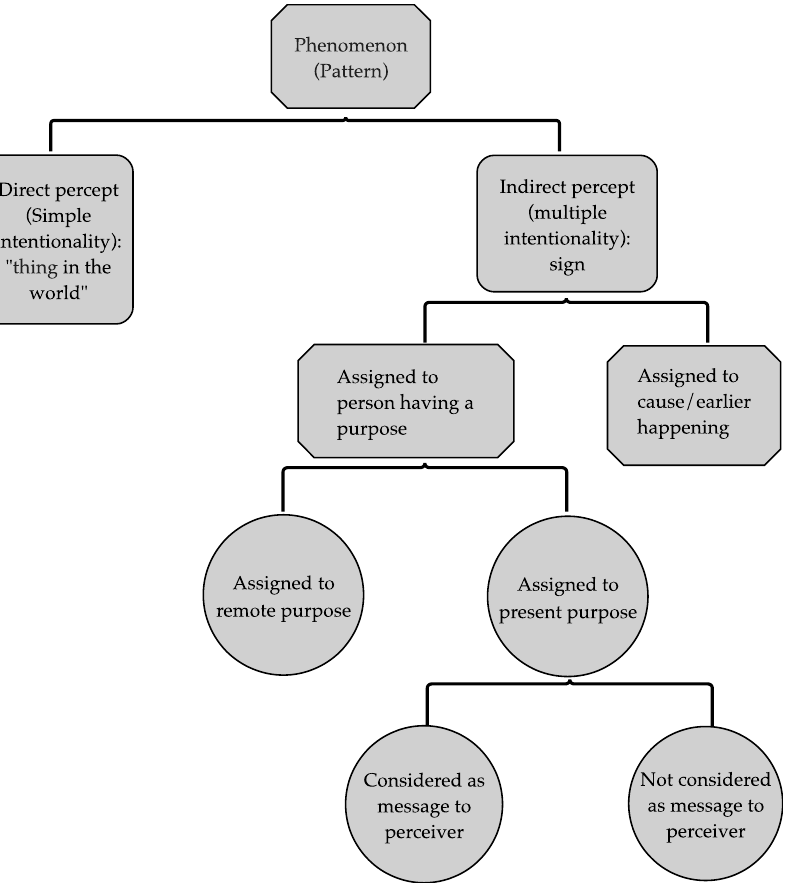
Figure 3. An analysis of patterns assigned to different levels and kinds of intentionality.